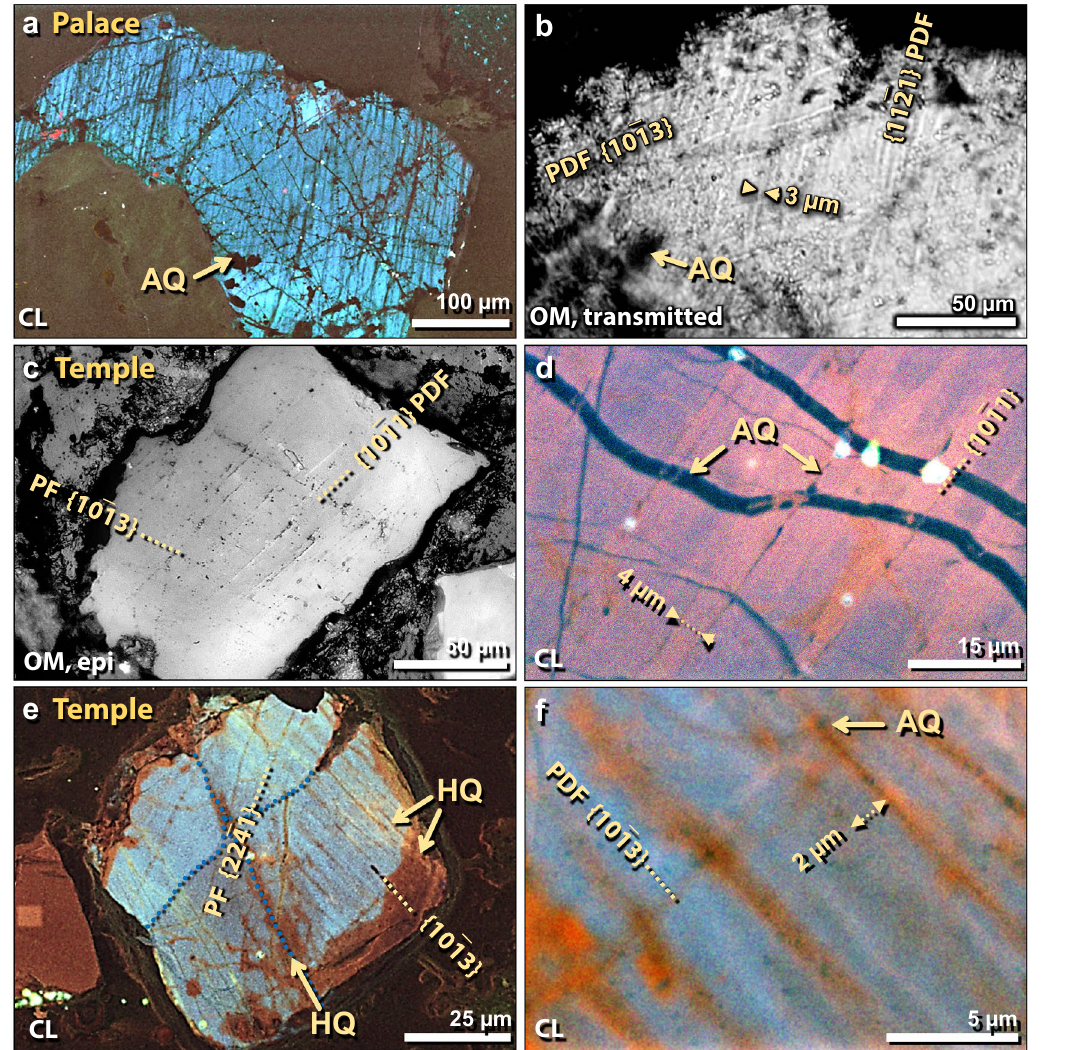
Figure 19. Shocked quartz grains. ( a ) SEM-CL image of 510-µm-wide grain from the palace. Border of grain and isolated interior regions are non-luminescent black under CL, indicating the presence of melted (amorphous) quartz (AQ). The unshocked quartz body is blue. ( b ) Transmitted light photomicrograph of same grain under crossed polars. Dark portions of grain are isotropic, indicative of amorphous melted quartz. Two closely spaced PDFs (~ 3 µm apart) are shown. ( c ) Epi-illuminated photomicrograph of shocked quartz grain from the temple. Two sets of lamellae are labeled; one is a PDF and one a wider-spaced PF. ( d ) SEM-CL close-up image, showing one set of black non-luminescent lamellae. Irregular black non-luminescent areas at arrows are amorphous quartz bands (AQ) that are isotropic in optical microscopy but not evident using SEM. Two lamellae have 4-µm spacing. ( e ) SEM-CL image of polycrystalline shocked quartz grain from the temple. Crystallites are marked by blue dotted lines. Two sets of lamellae are indicated, one confined to each crystallite. Large areas of grain appear black and red under CL, suggesting that portions of the exterior and interior of the grain melted and some recrystallized. The unshocked quartz body is blue. ( f ) SEM-CL image of grain in panel ‘ e ’; displays red lamellae with black centers, indicating a mix of amorphous quartz (black; AQ), healed quartz (red), and unaltered quartz matrix (blue). Two lamellae are ~ 2 µm with amorphous quartz 47 . Tectonic lamellae, i.e., ones that develop from slow strain along fault lines, commonly luminesce in blue or red wavelengths 59,61 , allowing for differentiation from impact-shocked quartz. One example from TeH is shown in Supporting Information, Fig. S6. U-stage measurements show that all five quartz grains display crystallographically oriented microfractures, planar fractures (PFs), feather features (FFs), and/or planar deformation features (PDFs), all of which are char- acteristic of impact-related shock metamorphism 51,61 . Altogether, the 7 TeH quartz grains/crystallites match 17 of 17 distinguishing characteristics of classic impact-shocked quartz (see Table 2), but match few charac- teristics of tectonically-shocked quartz. We also investigated quartz grains from two samples above and below